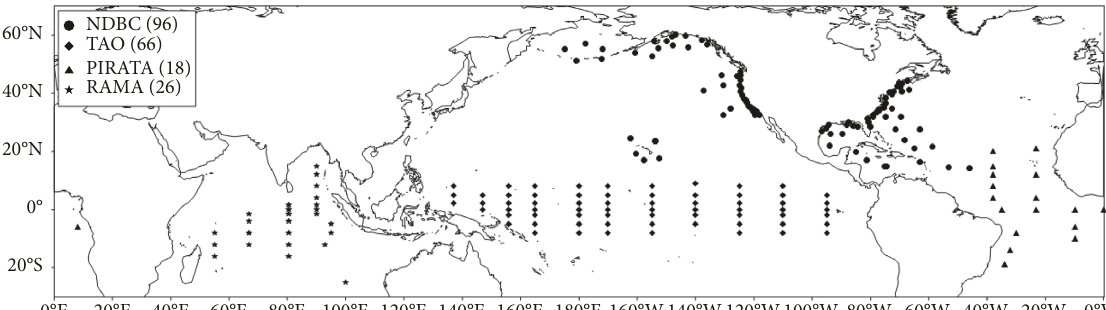
Figure 1: Distribution of the NDBC, TAO, PIRATA, and RAMA moored